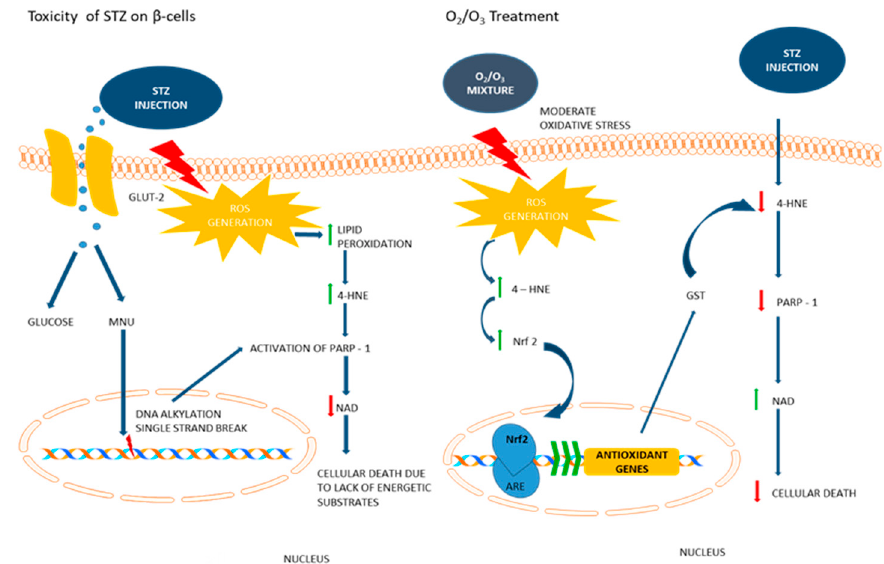
Figure 9. Proposed mechanism of ozone activity in STZ rats. Left panel: STZ induces increased reactive oxygen species (ROS) production, lipid peroxidation, accumulation of 4-hydroxynonenal (4-HNE) and DNA fragmentation; consequently, PARP-1 levels are increased in order to attempt DNA repair. Right panel: oxygen/ozone administration promotes a moderate oxidative preconditioning state, which in turn is able to increase Nrf2, GST production and anti-oxidative defense mechanisms. 4-HNE, PARP-1 and cellular death are decreased, this reduction resulted in higher levels of insulin and leptin and consequently improved the glycemia.